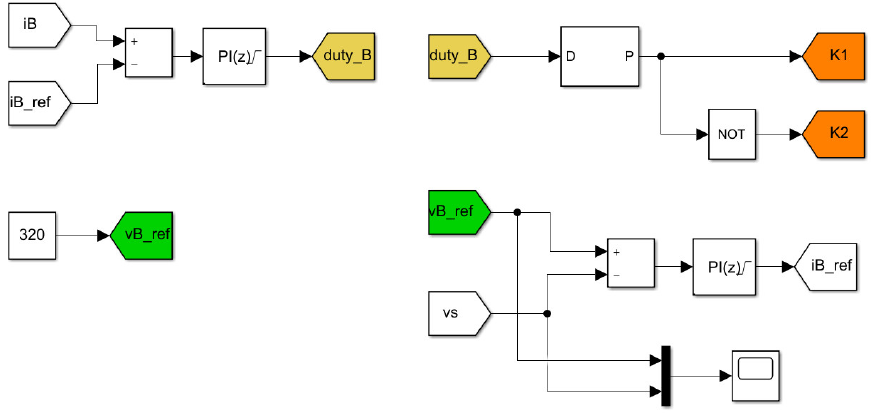
Figure 8. PID battery